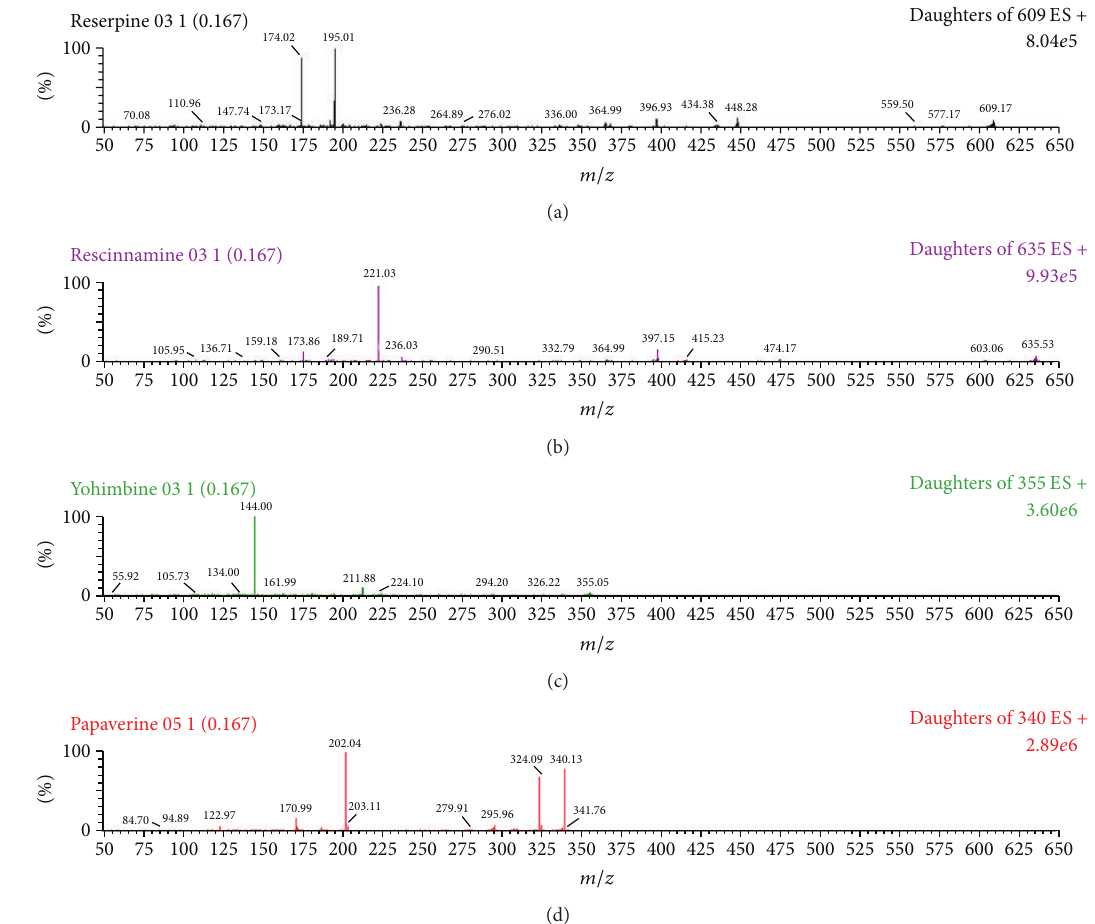
Figure 3: The MS/MS spectra (daughter ion) of reserpine (a), rescinnamine (b) yohimbine (c) and papaverine